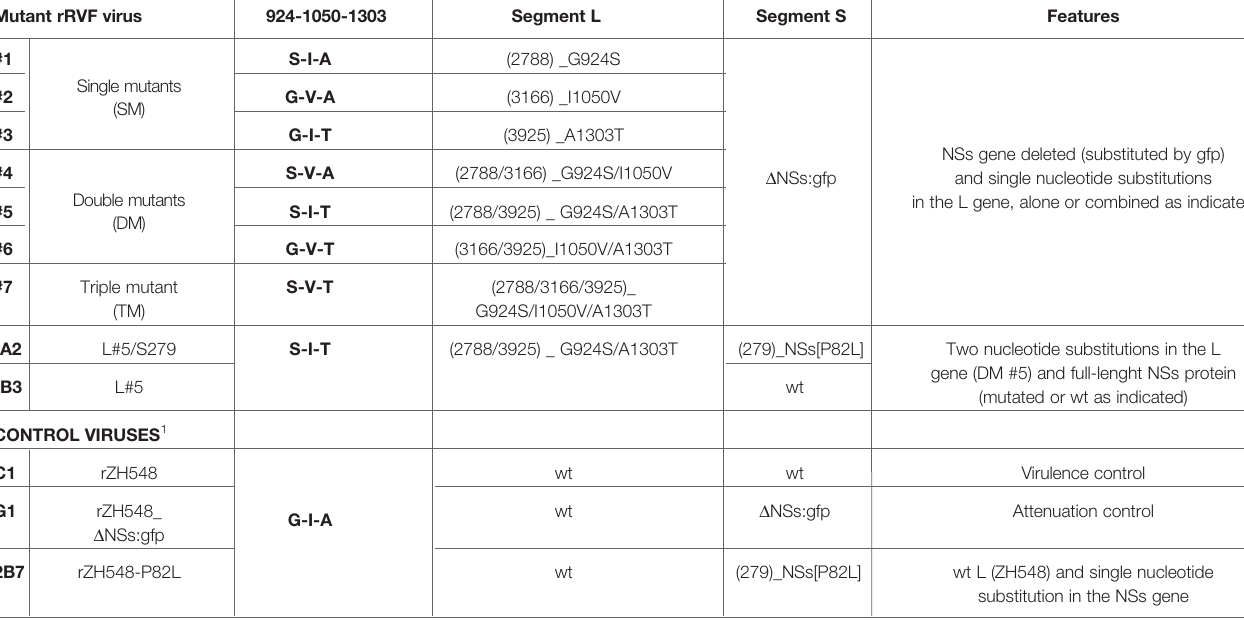
TABLE 1 | rRVFVs generated and analyzed in this work, corresponding to the combinations of the 3 single positions selected within the L-protein (segment L), together with the different genotypes regarding NSs gene (segment S). Mutant rRVF